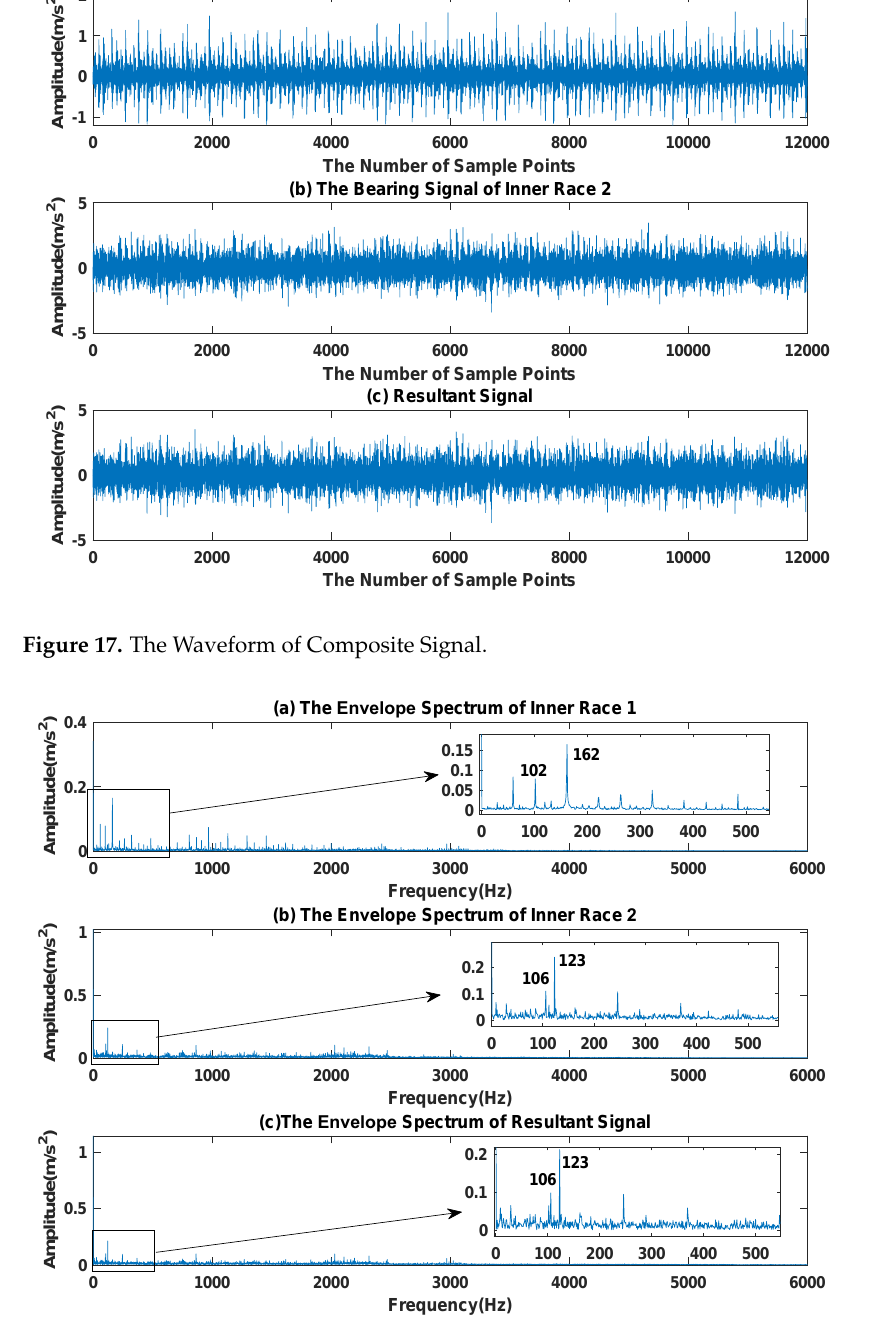
Figure 18. The Envelope Diagram of Composite